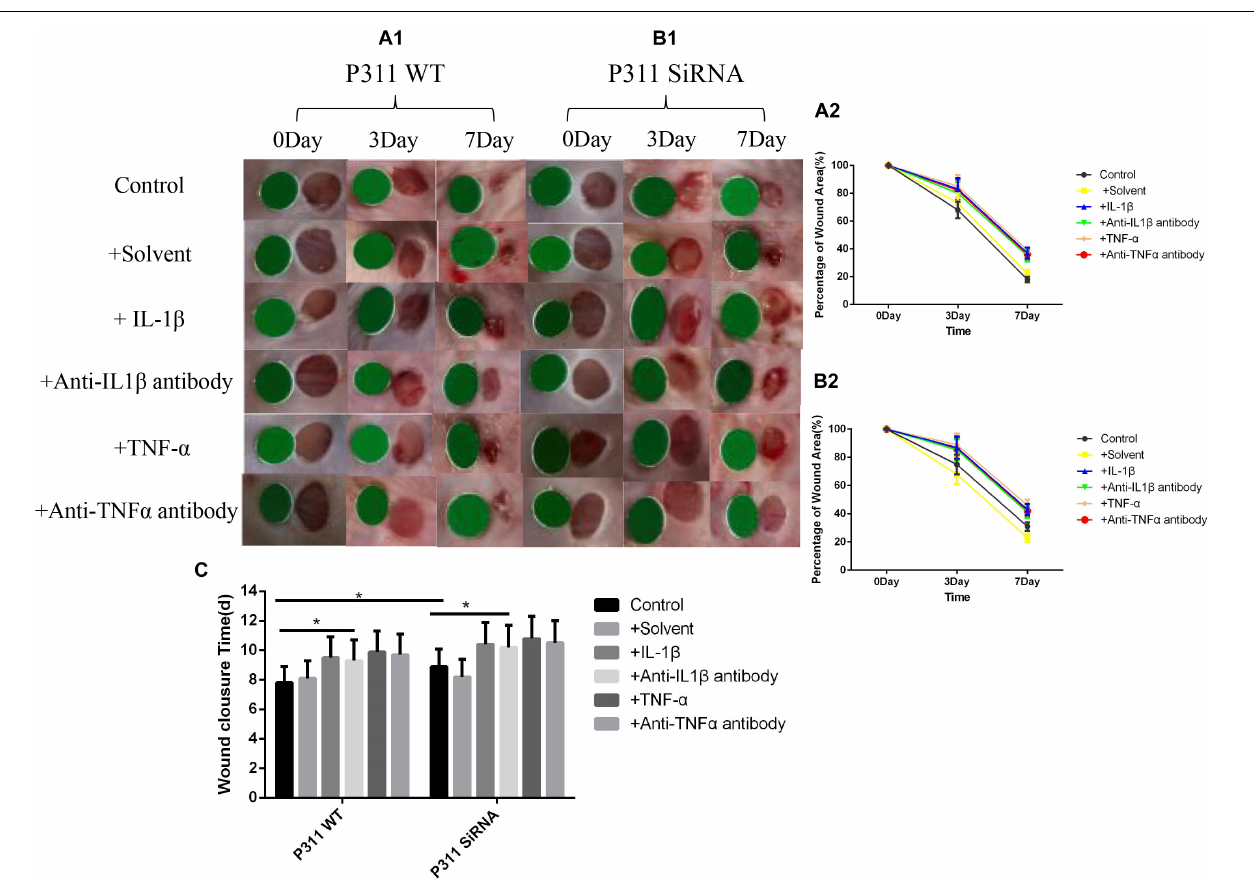
FIGURE 6 | Effects of various stimulus factors on wound healing. Mean ± standard deviation (SD) denote the experimental results; * indicates P < 0.05. (A1) P311 WT mice wound changes. (B1) P311 siRNA wound changes. (A2) Corresponding wound changes data of A1 . (B2) Corresponding wound changes data of B1 . (C) Complete wound healing times of A1 and B1